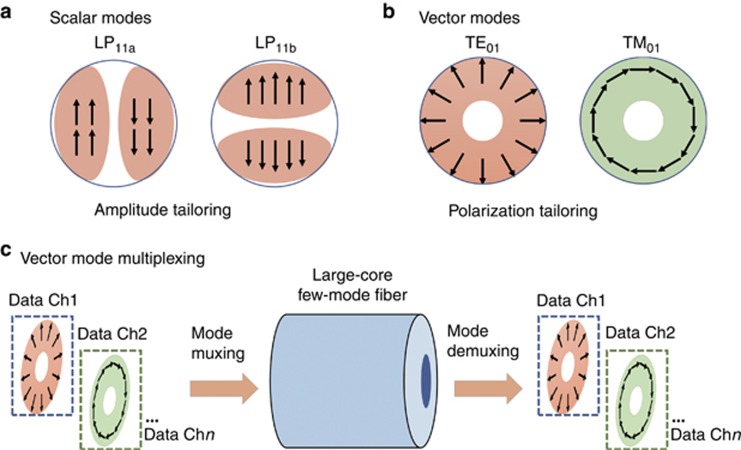
Comparison of (a) scalar modes (LP11a and LP11b) and (b) vector modes (TE01 and TM01). Amplitude, phase and polarization tailoring of beams can be used to produce a set of mutually orthogonal modes. (c) Concept of fiber vector eigenmode multiplexing. Integrated photonic vortex emitters are used to tailor the beams. Ch: channel; arrows in panels a and b: polarization of electrical fields.